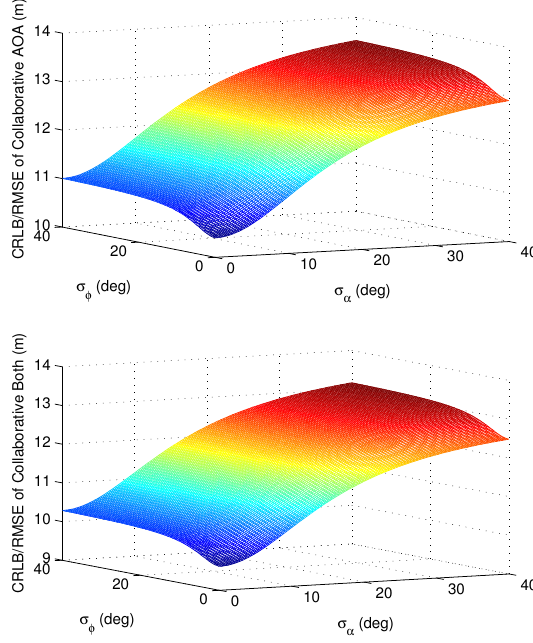
Figure 6. The impact of AOA measurements accuracy for user #1.